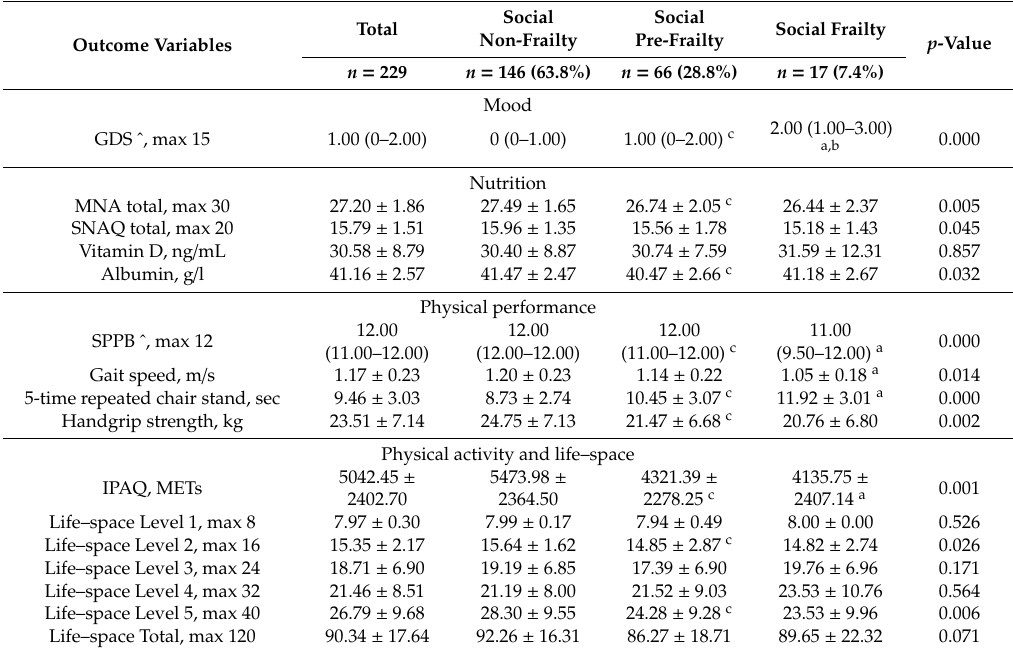
Table 4. Association of social frailty with